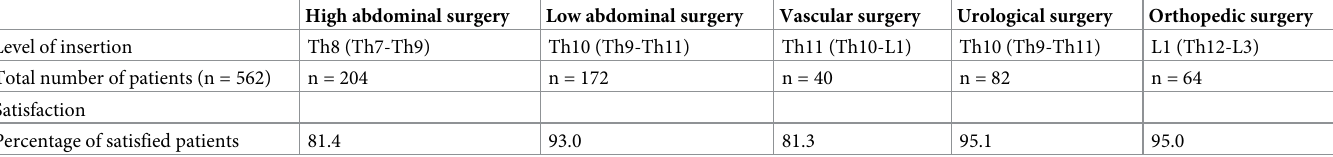
Table 1. Epidural data and patients’ satisfaction with epidural analgesia after different types of surgery. High abdominal surgery